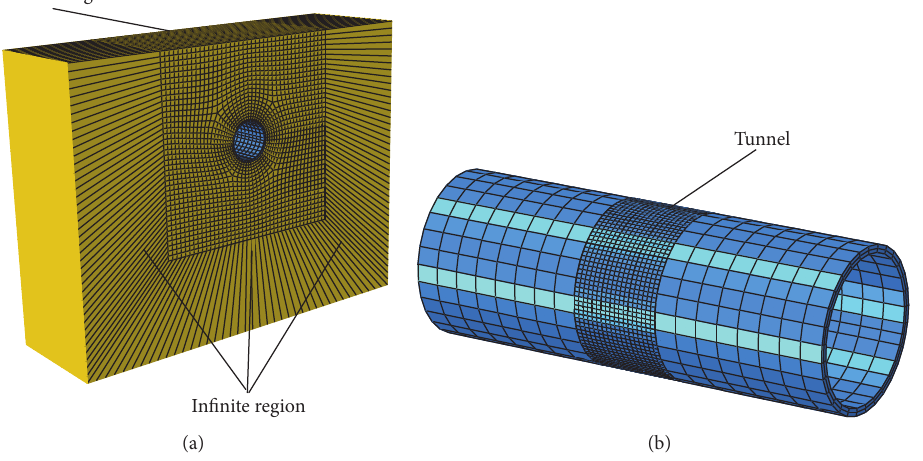
Figure 2: Employed finite element model: (a) the wall rock in the stratum; (b) the investigated tunnel lining.